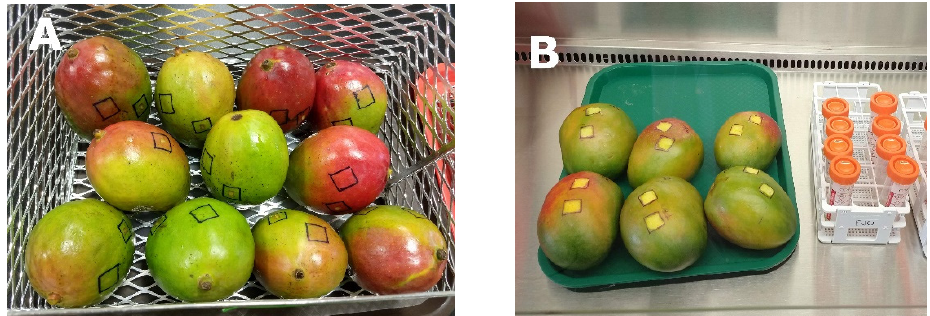
Figure 1. Methodology for mango inoculation and microorganism’s enumeration. ( A ) Inoculated marked areas on coated mango. ( B ) Mango surface samples for Salmonella spp. and C. gloeosporioides enumeration.